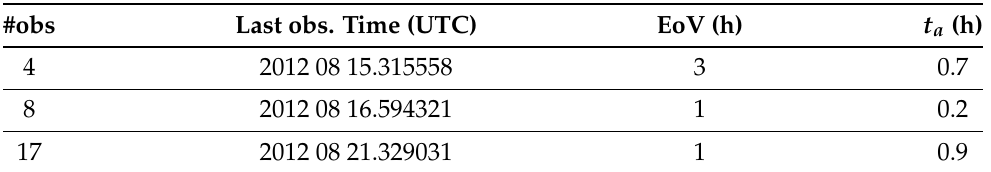
Table 3. Comparison between EoV, computed from the time of the last chosen observation, and actual observation time t a for asteroid 2012PB 20